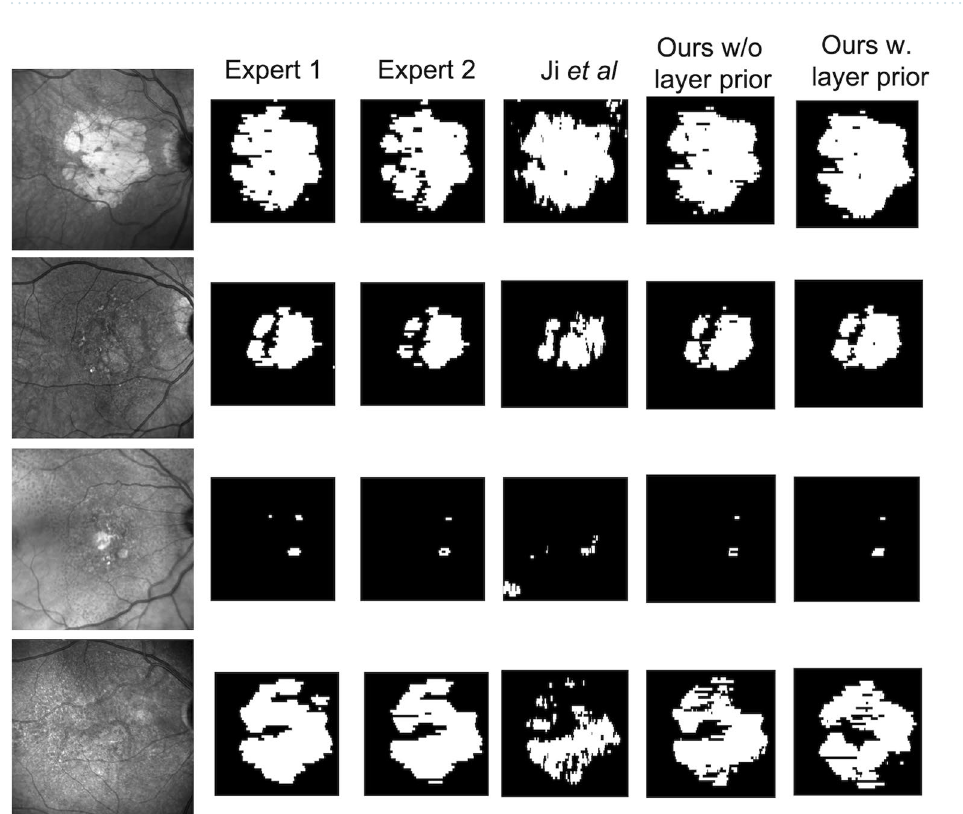
Figure 6. Examples of en face RORA segmentation. From left to right: a corresponding infra-red fundus image, RORA annotated by Expert 1, Expert 2, predicted by the method of Ji et al. 12 and predicted by our algorithm trained without and with layer prior. Our automatic segmentation approach was able to consistently segment a wide range of atrophic lesions and detected cases where hypertransmission was not clearly visible in infra-red